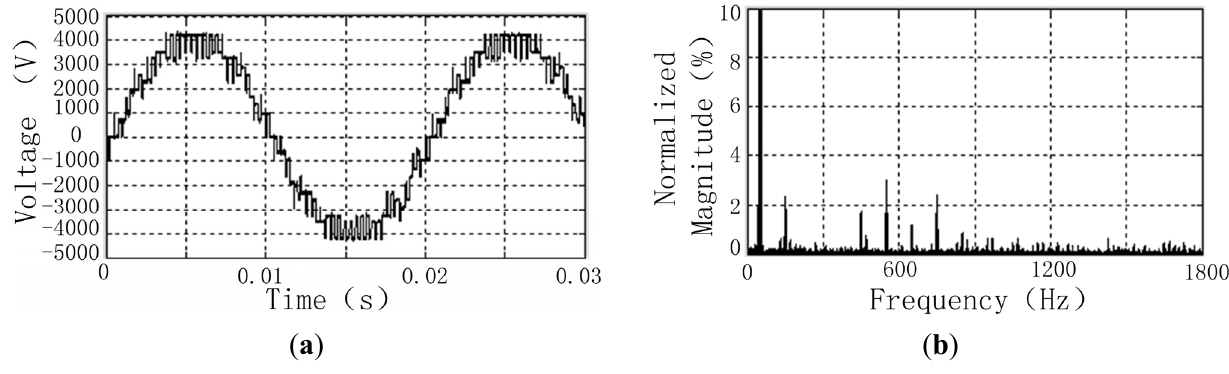
Figure 11. Result of the conventional PSCPWM when the second cell dc voltage is 690 V: ( a ) output voltage waveform; and ( b ) harmonics.